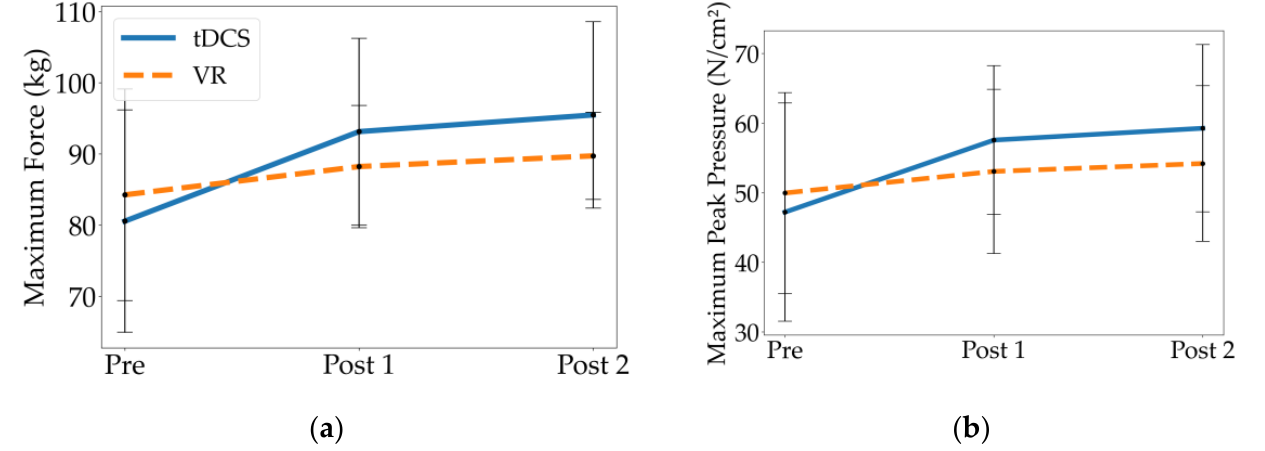
Figure 4. Mean and standard deviation of kinetic parameters at Pre, Post 1, and Post 2 for the tDCS and VR groups, including ( a ) maximum force, and ( b ) maximum peak pressure.